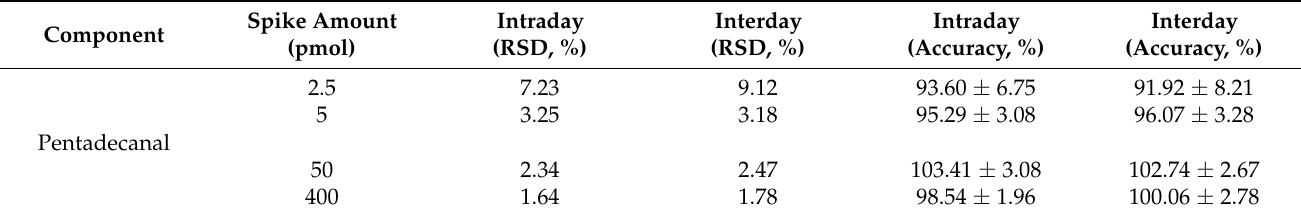
Figure 2. Optimal conditions for the 5,5-dimethyl cyclohexanedione (5-dimethyl CHD) derivatization of pentadecanal and the effect of derivatization. ( A ) 5,5-Dimethyl CHD concentration, ( B ) acetic acid concentration, ( C ) ammonium acetate concentration, ( D ) temperature, and ( E ) reaction time for the formation of pentadecanal derivatives. Pentadecanal (100 pmol) spiked into the S1PL reaction buffer and derivatized with 5,5-dimethyl CHD at various conditions. After solid-phase extraction, we analyzed the lipid aldehyde content in the dried samples. Each point represents the mean ± SD of triplicate analyses. Table 1. Precision and Accuracy of Pentadecanal in F9-2 Cell